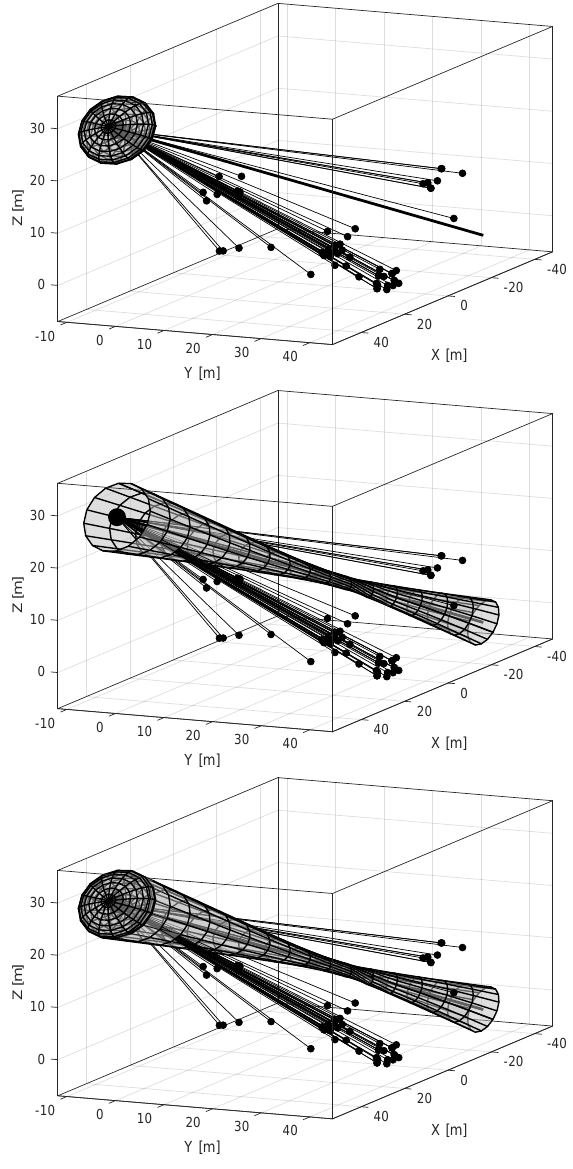
Figure 9. 99% confidence regions. Top: Position of the pro- jection center as an ellipsoid. Middle: Straight line, here the optical axis of the camera system. Bottom: Half-line defined by projection center and optical axis. The confidence region is most narrow in the vicinity of the 3D points used for spatial